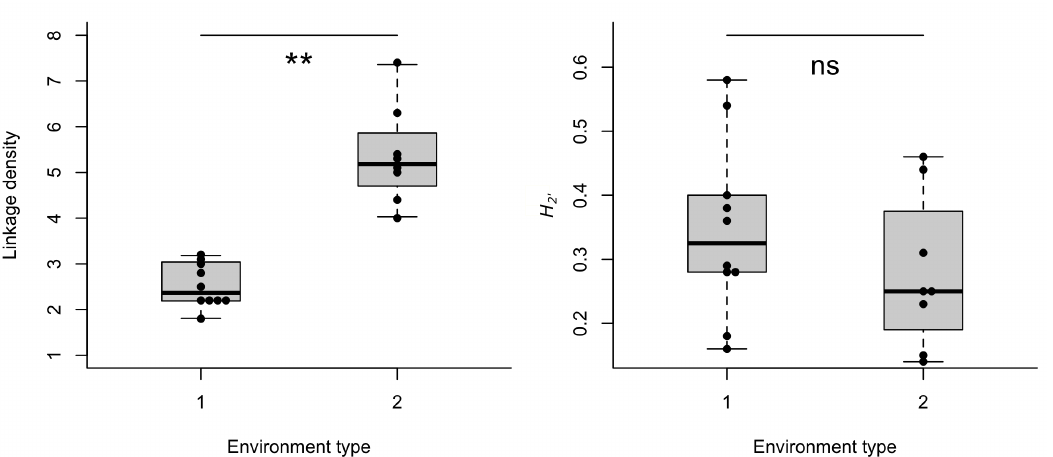
Figure 3. Ecological metrics of networks established from bees ( O. bicornis ) and flowers (artificial flowers). Measures were recorded in flight cages simulating two different environment types (1 and 2, see methods). * p < 0.01, ** p < 0.001, ns = non-significant.